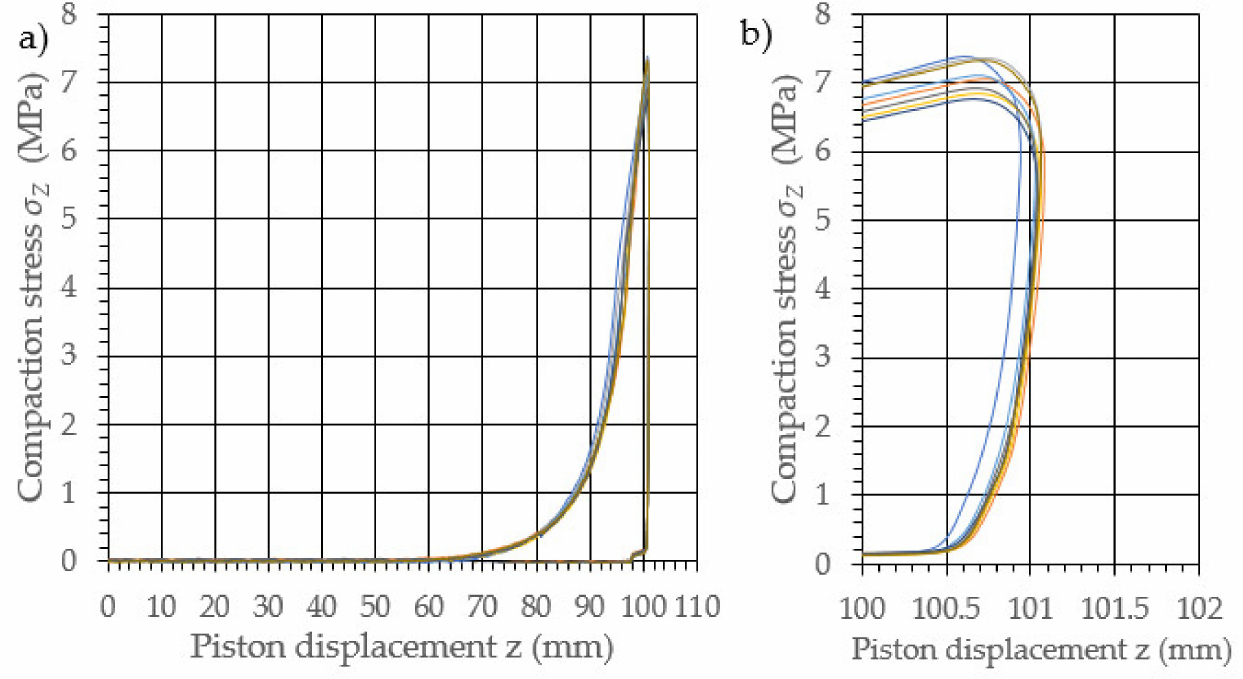
Figure 7. Characteristic curves for the compression with relaxation of dry ice with a final density of 1412.3 kg/m 3 . ( a ): The overall course of the characteristics; ( b ): an enlarged relaxation section of the compacted